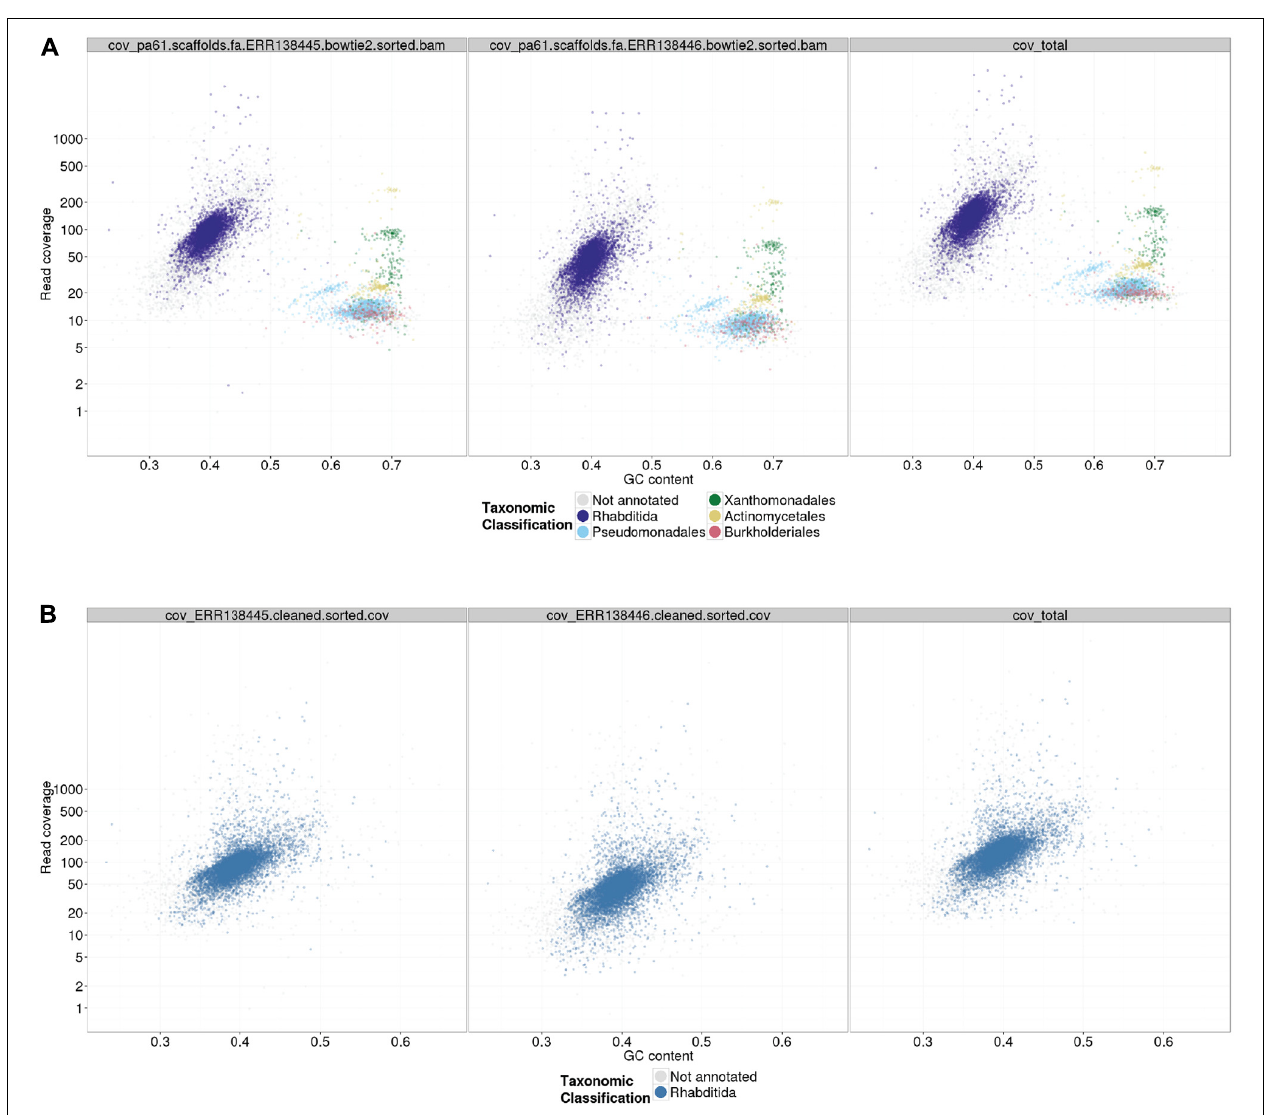
logarithmic scale). Contigs are colored according to taxonomic order of their best megablast match to the NCBI nt database (with E -value cutoff < 1e − 05). Any taxonomic order annotation associated with 1% or more of annotated contigs is marked with a color; contigs without an annotation from these are in gray. (B) TheTAGC plot from an ABySS assembly of the Caenorhabditis sp. 5 data after removal of the bacterial contaminants. Annotation as in part (A)